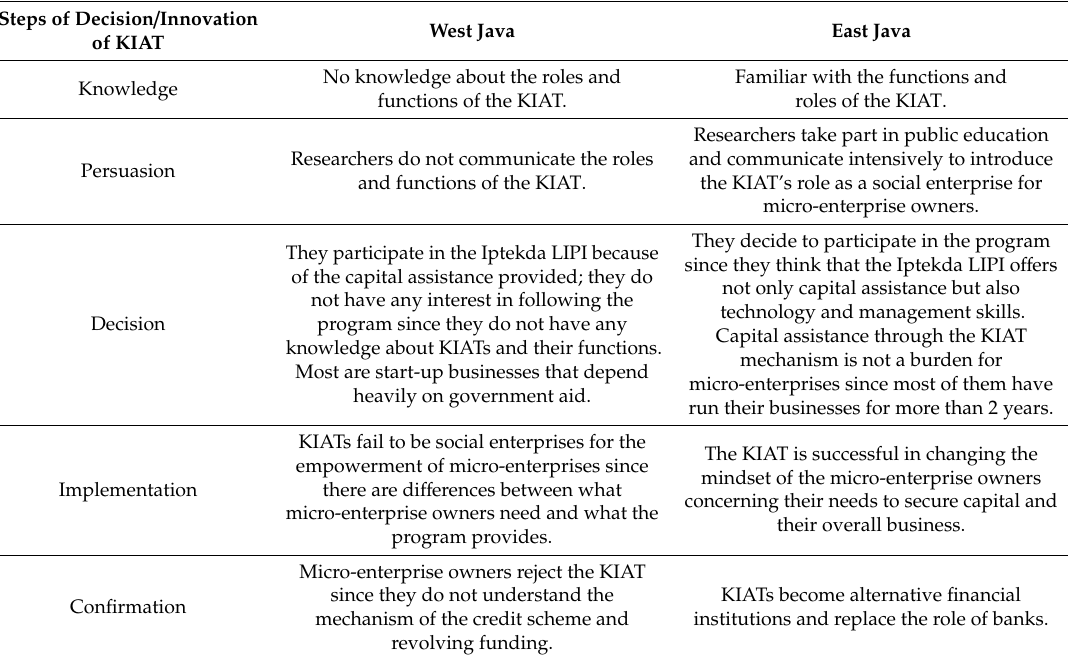
Table 3. The acceptance of KIATs as social enterprises for empowering SMEs based on the steps of the innovation–decision process